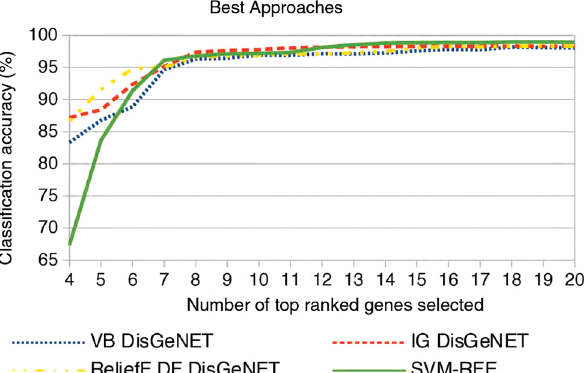
Figure 6: Classification accuracies on dataset I of the best performing approaches for the respective traditional gene selec- tion